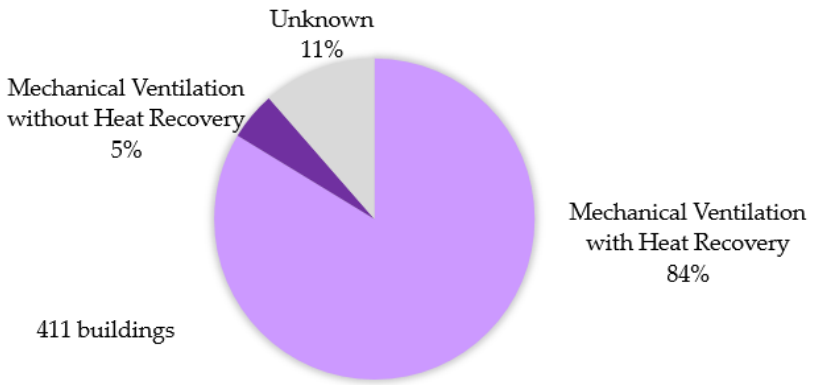
Figure 13. Mechanical ventilation systems declared.